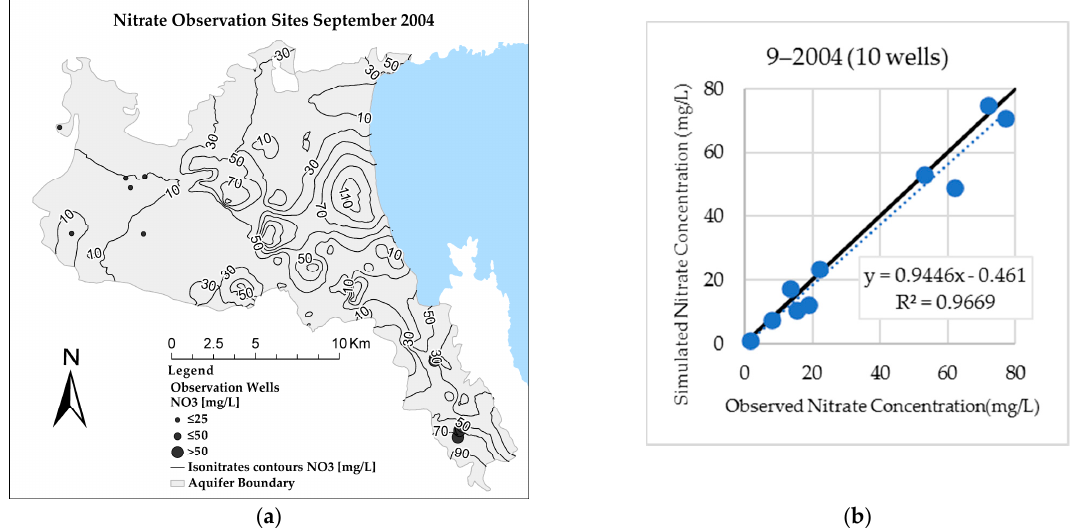
Figure 18. ( a ) Isonitrates contours for September 2004 and ( b ) scatterplot of simulated against observed nitrates concentration values.